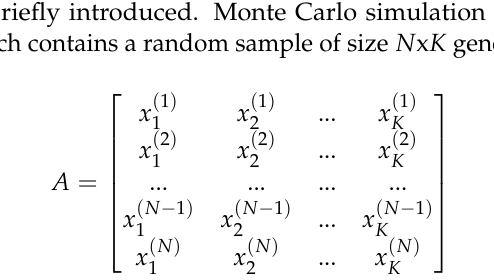
. 3 and ˆ σ i for the toy i